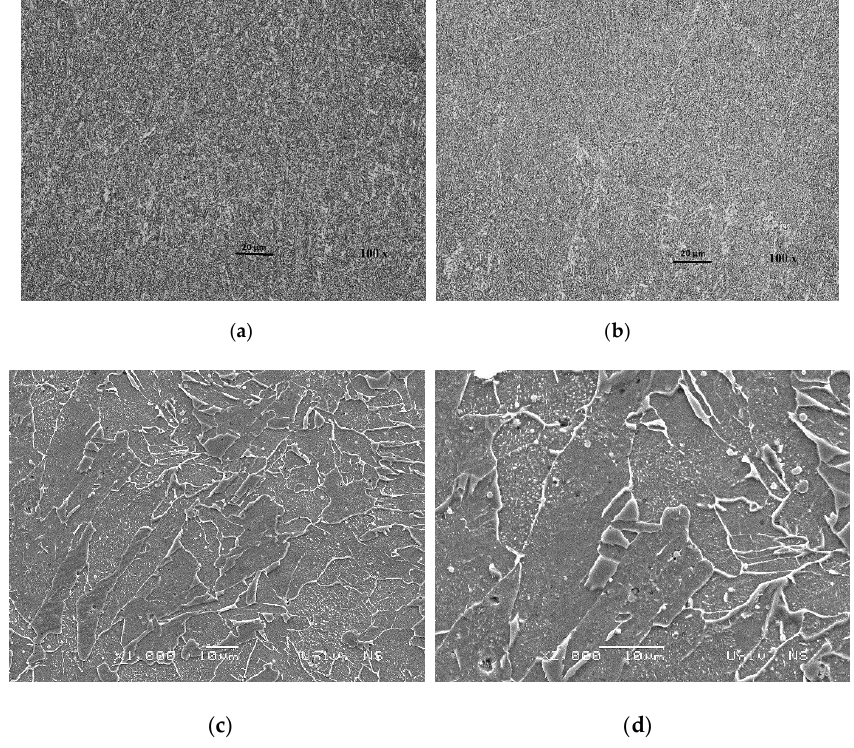
Figure 12. OM ( a , b ) and SEM ( c , d ) microstructure of WM created by electrode No.2.1.